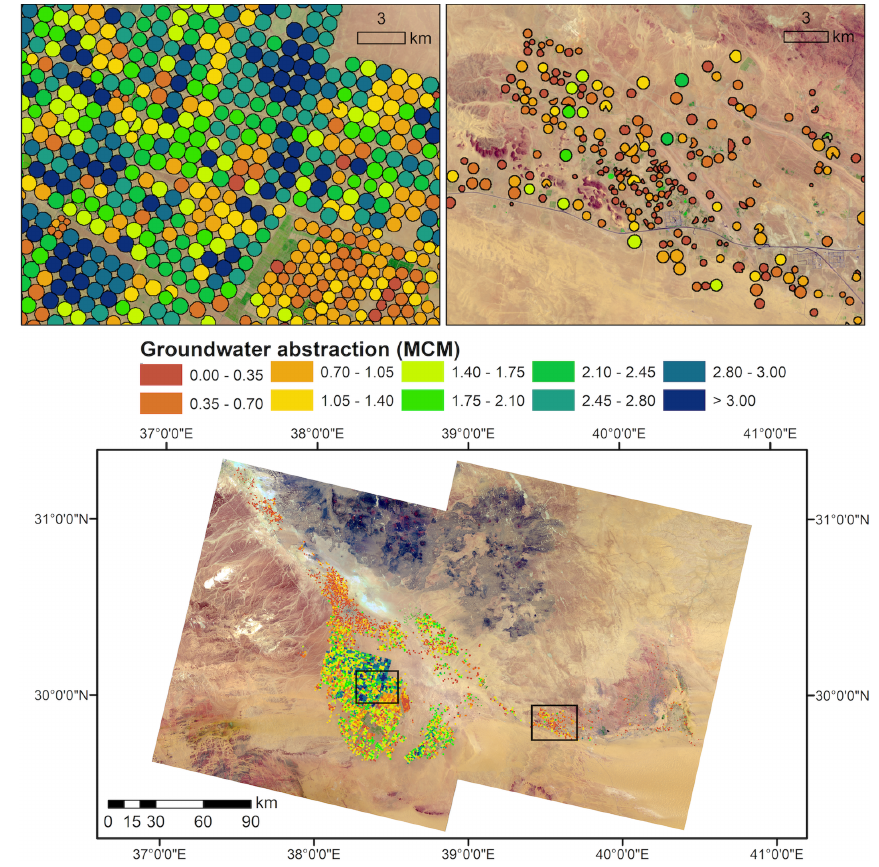
Figure 11. Map of annual groundwater abstraction in MCM for the Al Jawf agricultural region. Values were obtained for individual fields, as seen in the examples shown at top featuring one zone with high levels of abstractions (top-left) and another zone with a smaller density of fields and lower values of abstraction (top-right). The background shows the same Landsat 8 images as in Fig. 2.